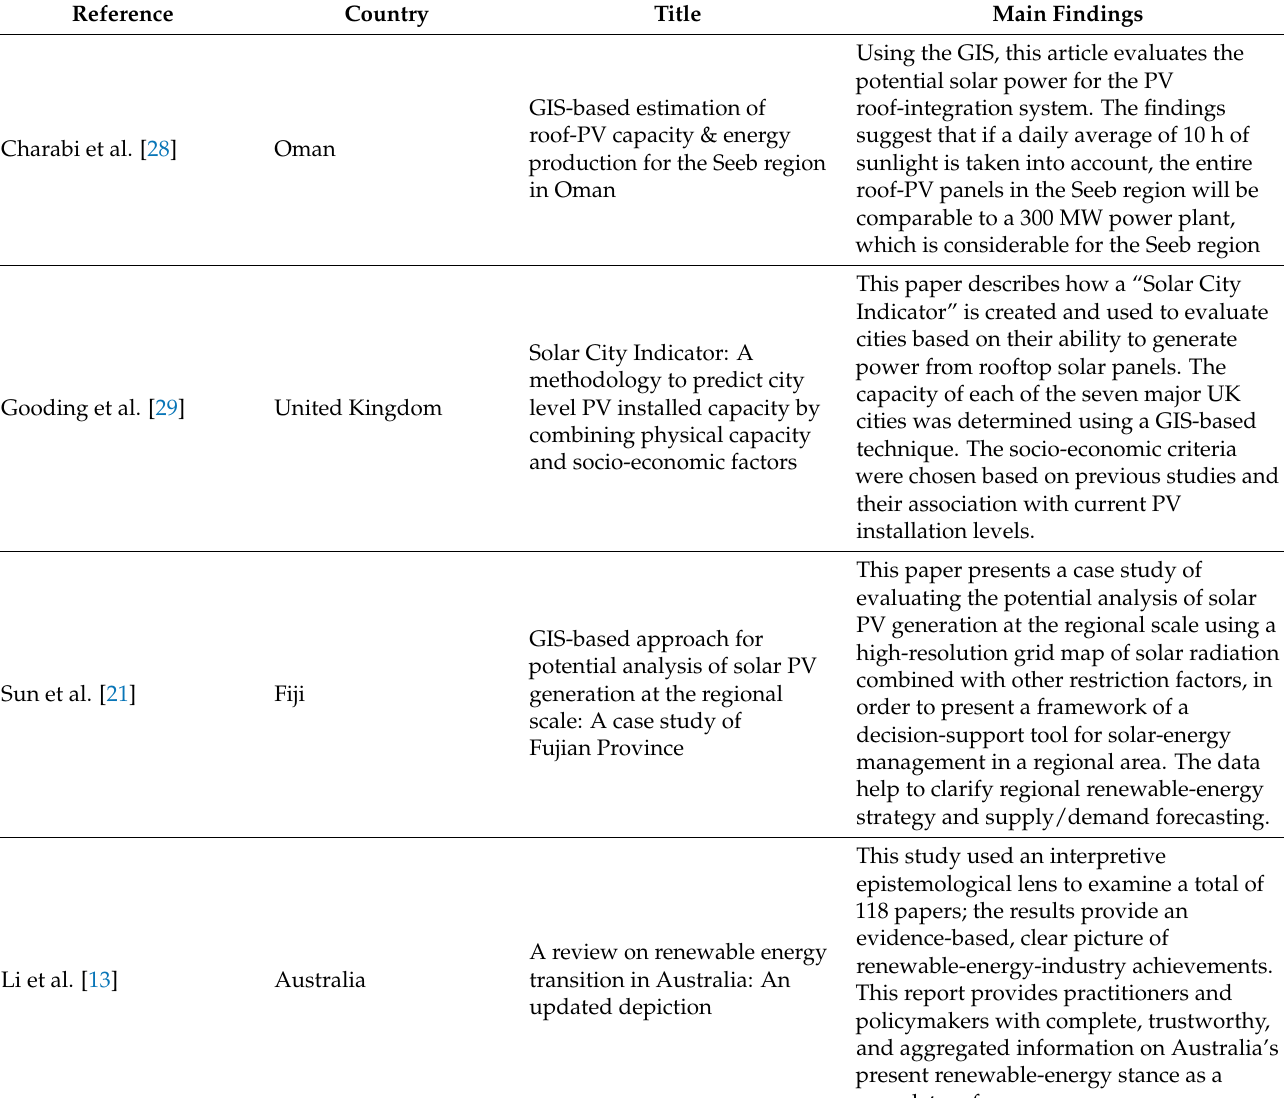
Table 1. Studies on assessment of solar-energy potential using GIS and deep